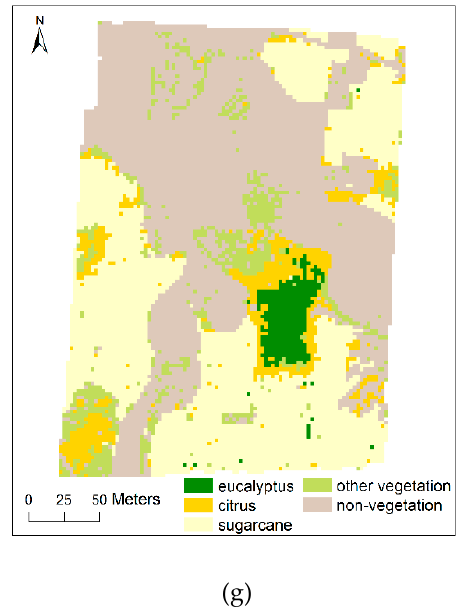
Figure 6. Classification results of the study area for multi-scale UAV images based on SVM classifier. The UAV image and the ground truth reference image of the study area are available in Figure 1 and Figure 2, respectively; ( a ) 0.025 m (segmentation scale: 2500, feature number: 40); ( b ) 0.05 m (segmentation